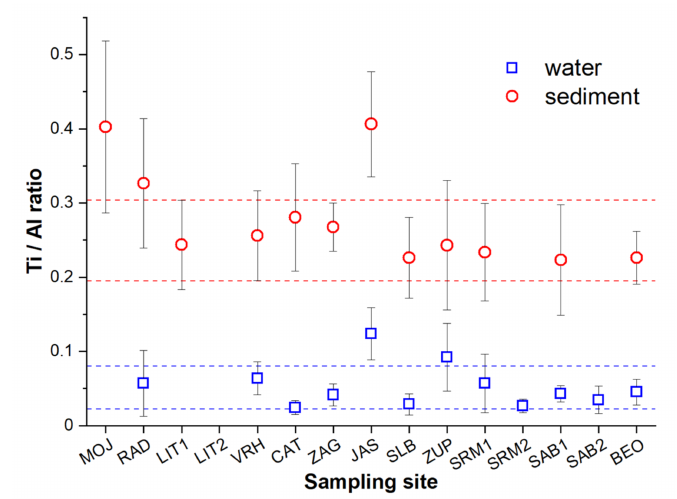
Figure 5. Ti/Al ratios determined in NPs detected in water (blue squares) and sediment extracts (red circles), collected along the Sava River. Each data represents the mean ± STD of N replicates (N = 4 for water and N = 6 for sediment samples). The median value ± std for each sample type was calculated by considering all sampling sites, and its lower (median − std) and upper limit (median + std) are shown as dotted lines.